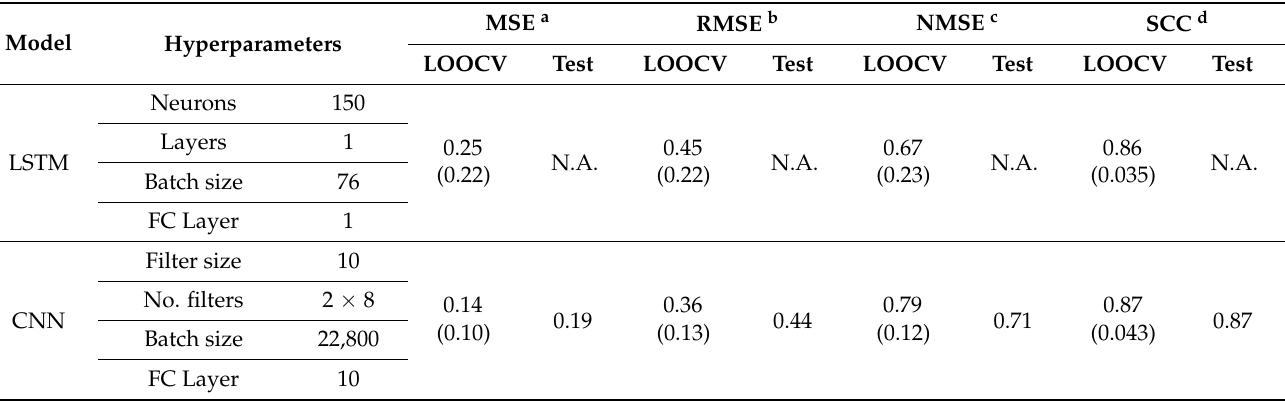
Table 2. CNN and LSTM accuracy in estimating energy expenditure considering the LOOCV algo- rithm and the test